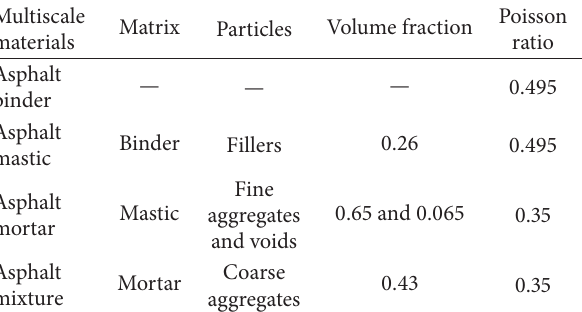
Table 2: Multiscale materials properties and